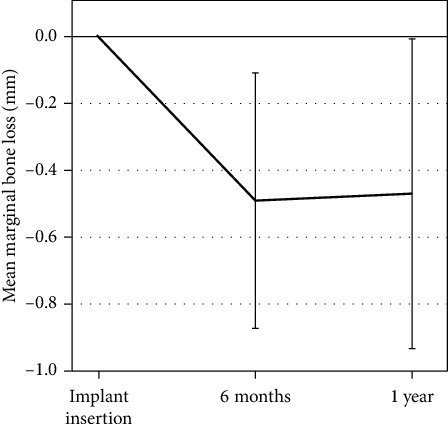
Mean marginal bone remodeling from the time of implant placement to 1-year follow-up. Error bars show standard deviation (SD).